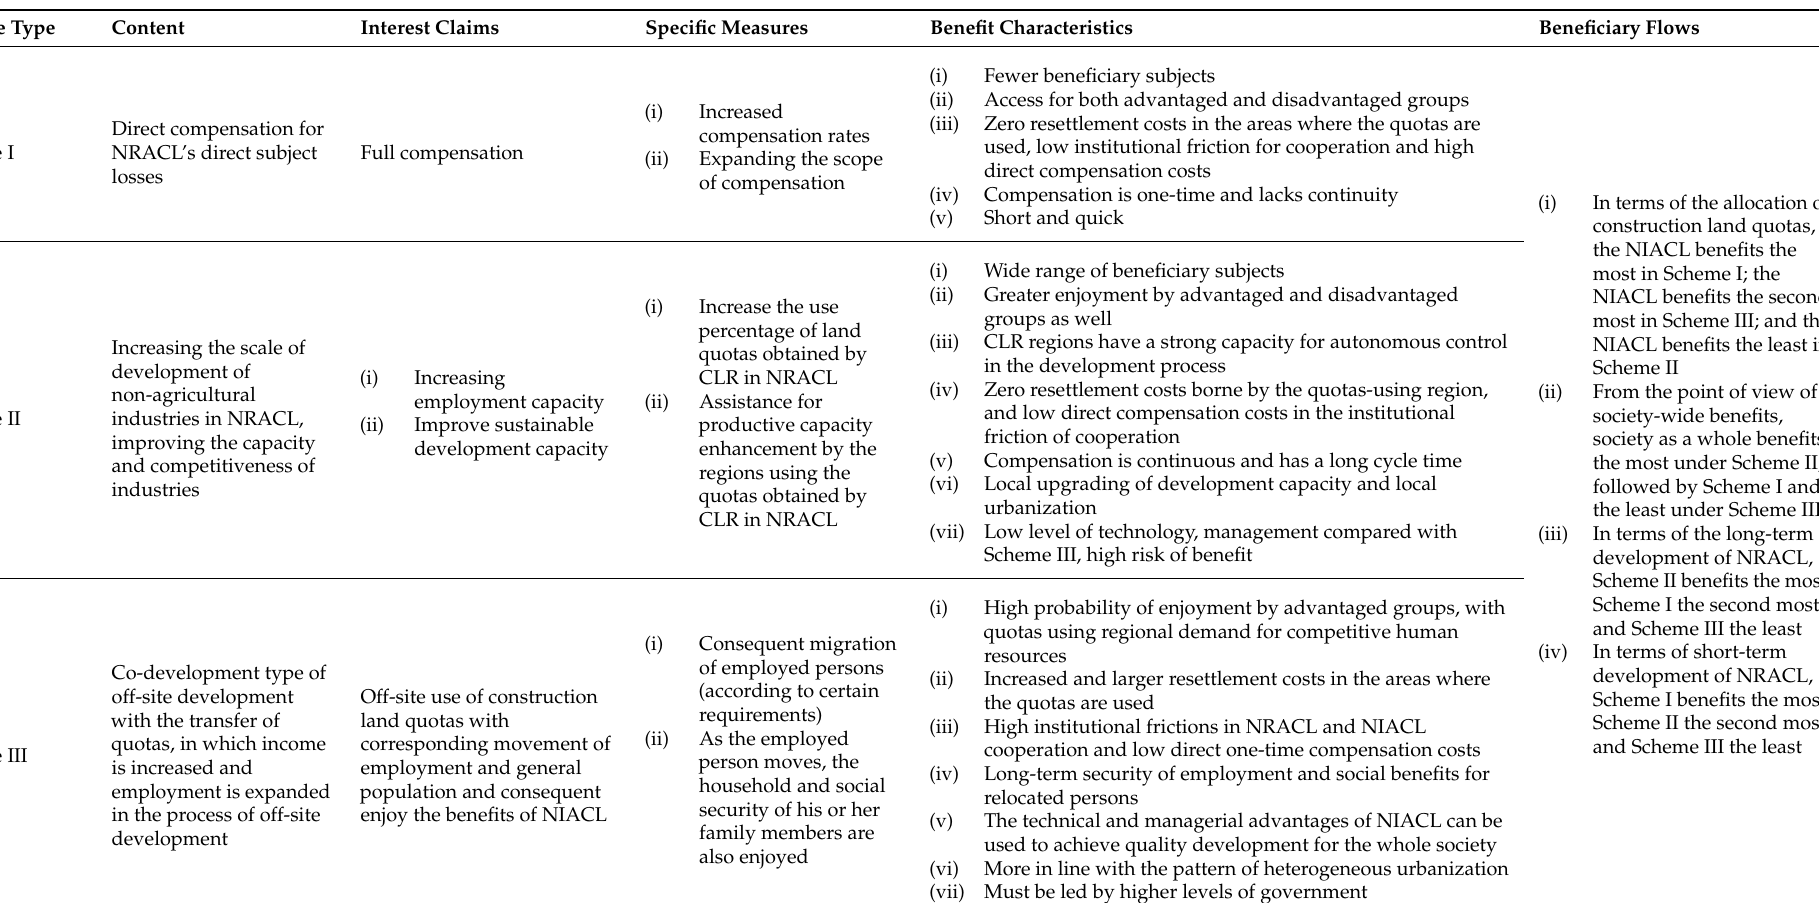
Table 1. Compensation scheme for the benefits of reduction in